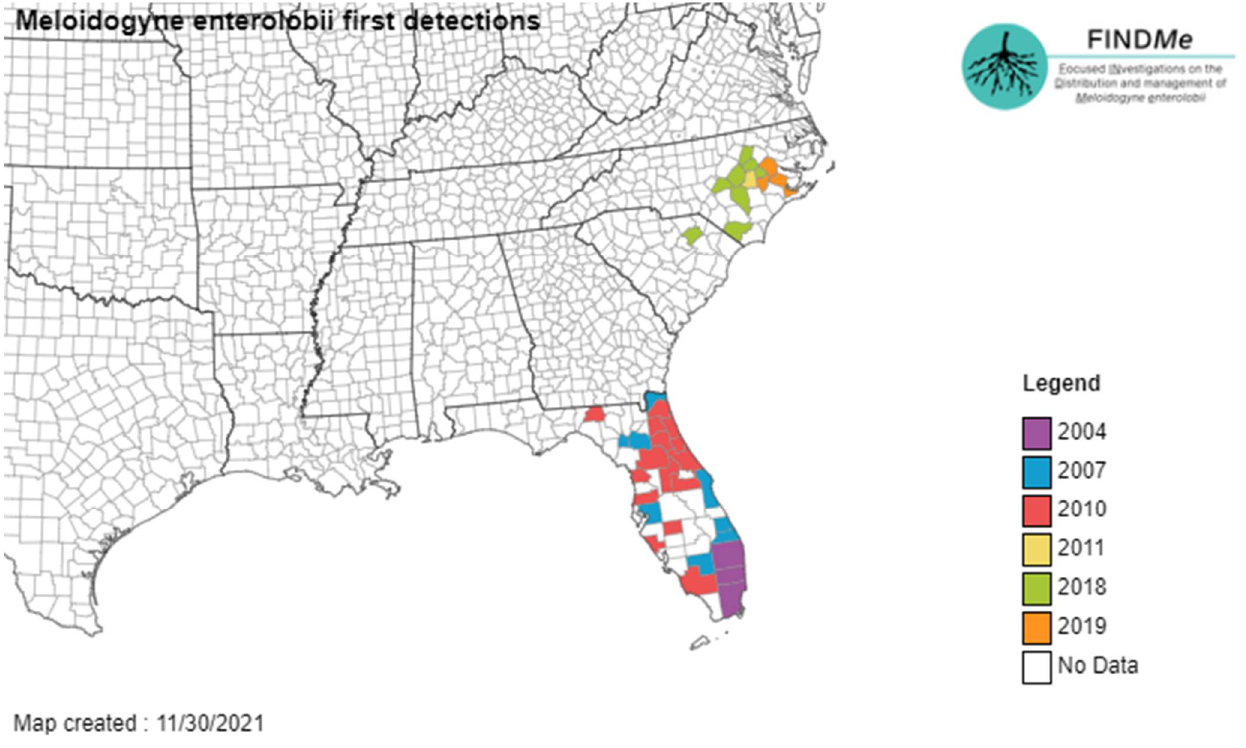
Figure 8. Continental U.S. distribution map of Meloidogyne enterolobii (source, FIND Me. org)